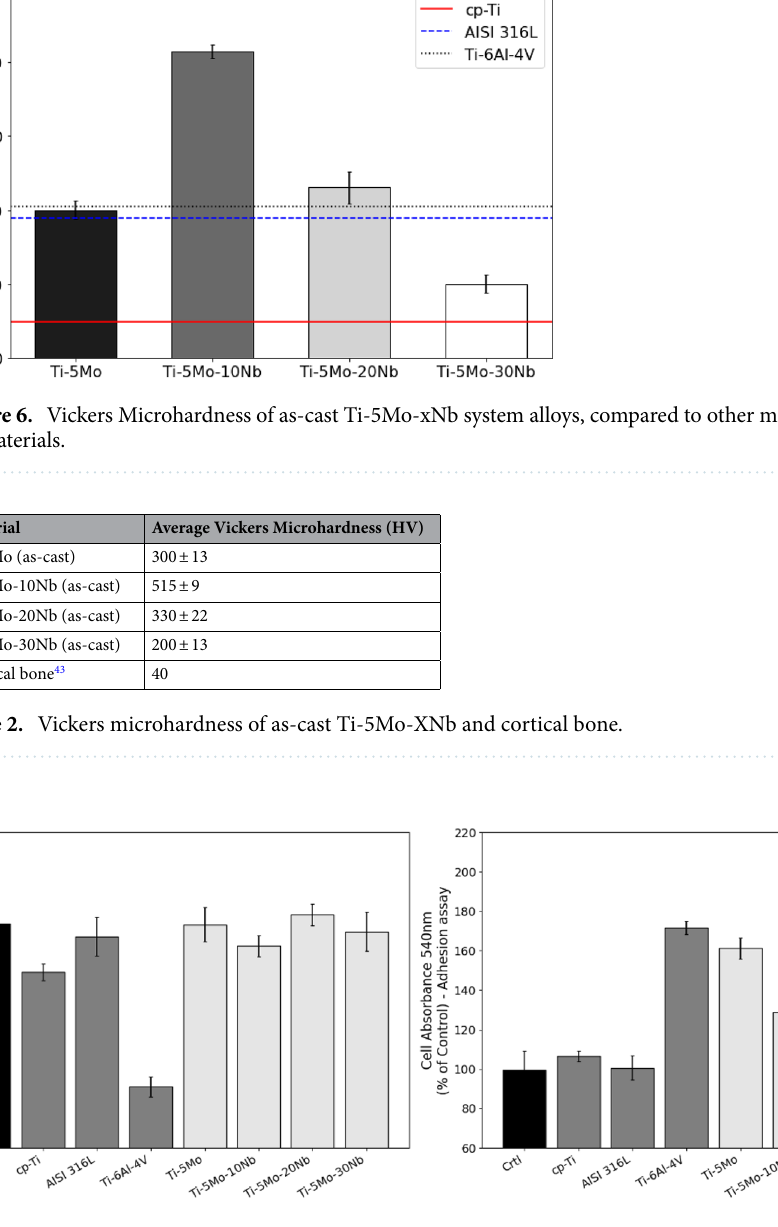
Figure 7. Cell viability (left) and adhesion (right) assays of as-cast Ti-5Mo-Nb system alloys and some other metallic